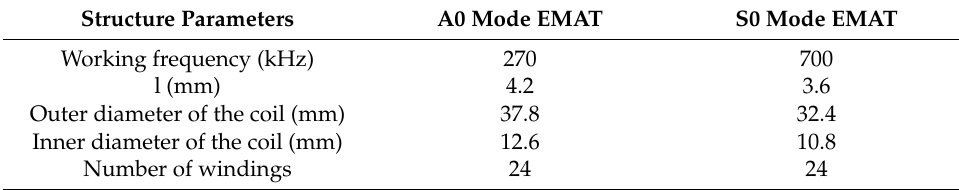
Table 1. Structure parameters of single A0-mode EMAT and single S0-mode